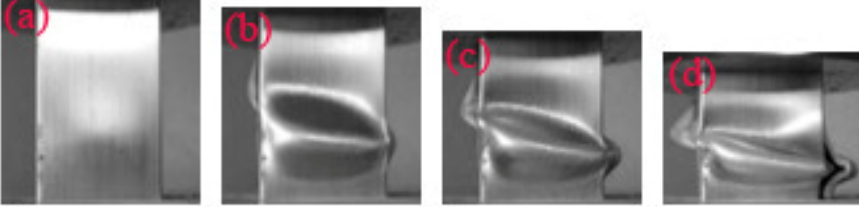
Figure 10. Typical deformation of the pyramid lattice material-filled tube with a relative density of the lattice material of 0.41 at a strain of ( a ) 2.6%; ( b ) 10%; ( c ) 20%; ( d ) 30%.